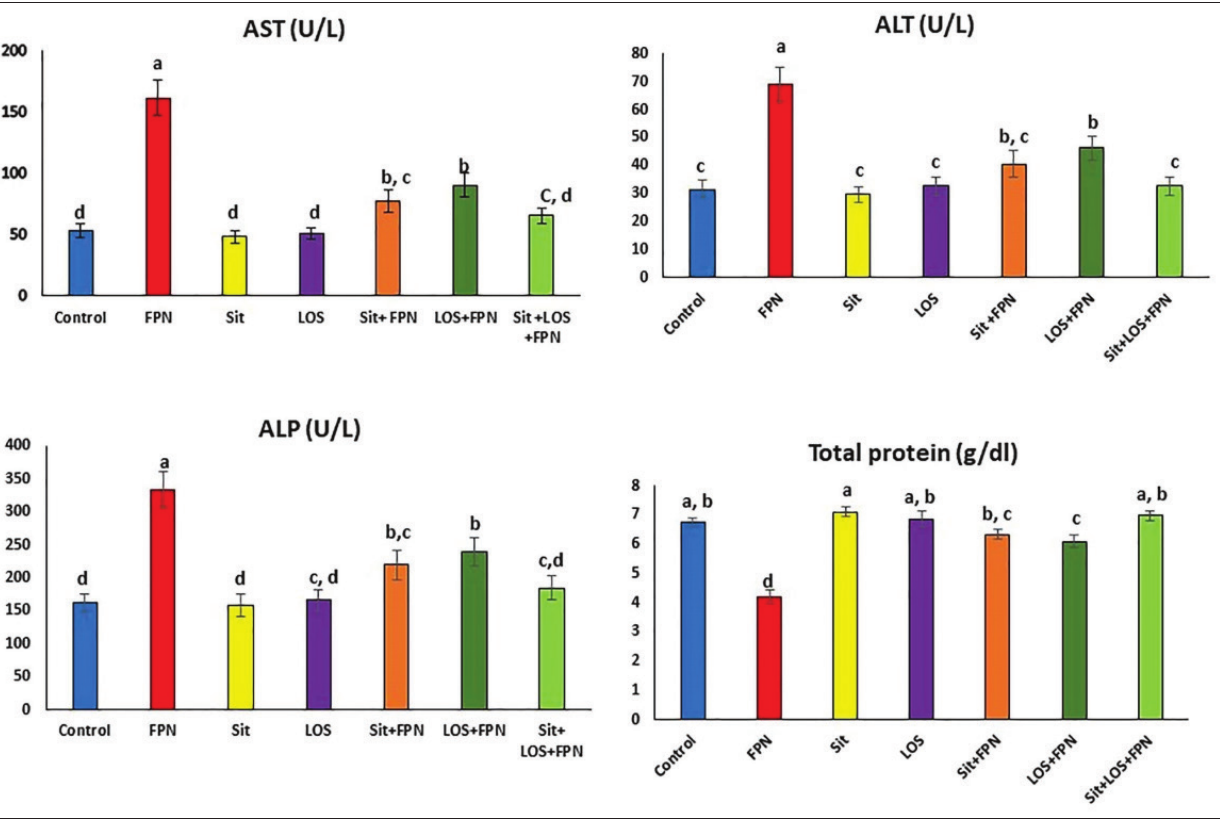
Figure-1: The effect of sitagliptin and losartan on serum concentrations of hepatic injury biomarkers in FPN-intoxicated rats. Data are presented as Mean±SEM (n=6). Means with different superscript letters (a-d) are statistically significant at (p≤0.05). FPN=Fipronil; Sit=Sitagliptin; LOS=Losartan; AST=Aspartate aminotransferase; ALT=Alanine aminotransferase; ALP=Alkaline